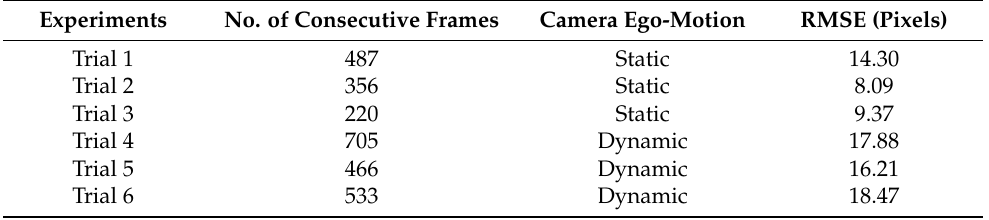
Table 3. Comparison of root mean square error (RMSE) between static and dynamic camera ego-motion.